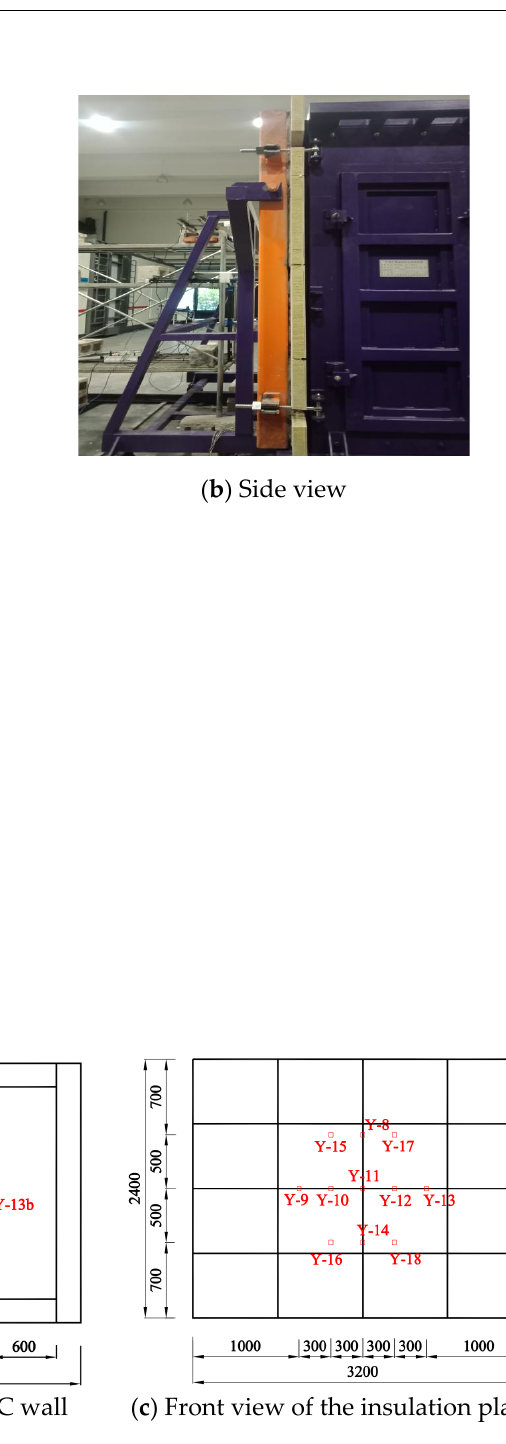
( b ) Pulse duration Figure 4. Loading protocol. Table 1. Calculation coefficients corresponding to different heights. Height (m)